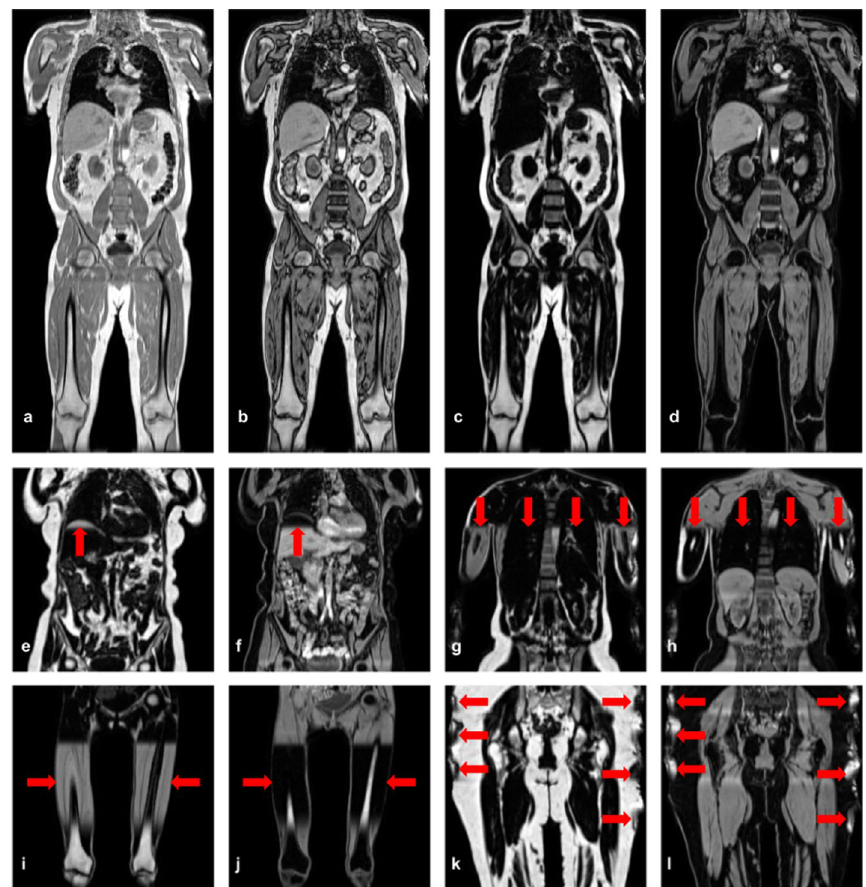
Fig. 1 Dixon MRI data provided for representative UK Biobank participant: a in-phase, b opposed-phase, c fat and d water signals. Fat and water series with a partial swap e , f at the top of the liver, g , h a swap in a portion of the left arm and torso, i , j a swap in both legs and k , l localised swaps due to field inhomogeneities at the boundary of the field of view. Red arrows indicate fat-water swaps